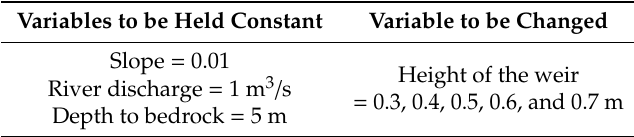
Table 1. Di ff erent modeling scenarios adopted in this study. Variables to be Held